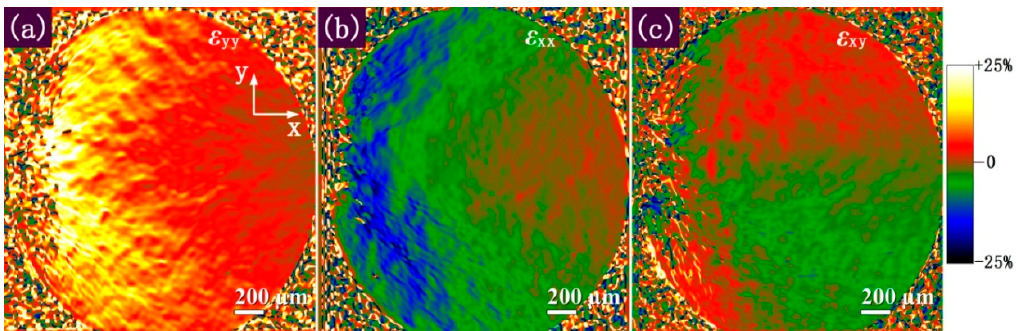
Figure 7. Strain fields at a maximum load 420 N corresponding to Figure 3f measured by using the GPA method: ( a ) ε yy strain field; ( b ) ε xx strain field; ( c ) ε xy strain field. Metals 2018 , 8 , x